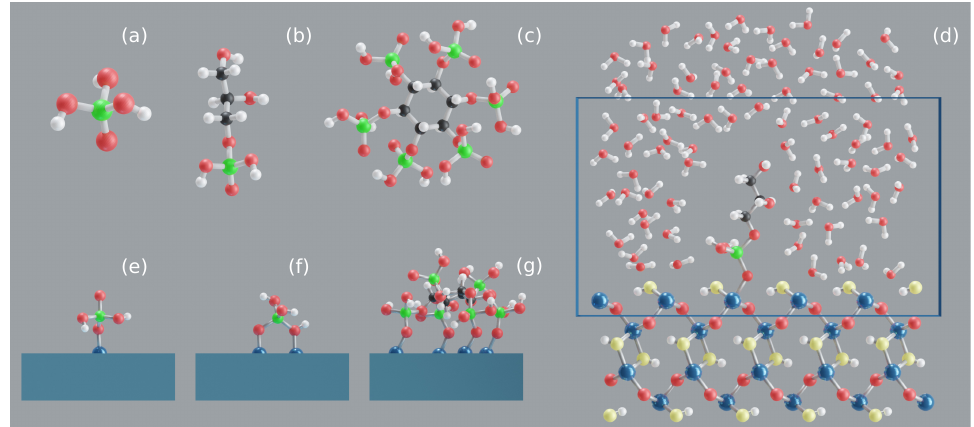
Figure 1. OP ( a ), GP ( b ), IHP ( c ), solvated goethite–GP complex highlighting QM box ( d ), goethite– OP M motif ( e ) and B motif ( f ), goethite–IHP 4M motif ( g ). Blue, red, yellow, white, black and green colors correspond to iron, oxygen, hydroxyl oxygen, hydrogen, carbon and phosphorus atoms,